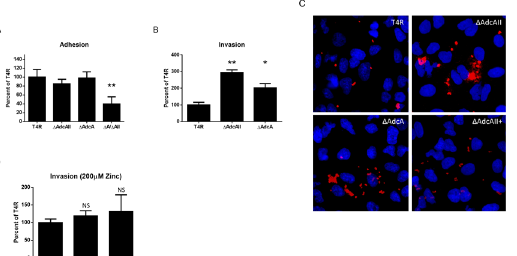
Fig 3. Effect of AdcA and AdcAII on adhesion and invasion in A549 cell line. A) Adhesion relative to T4R (100% representing approximately 0.9% of inoculum adhered). Bacteria were incubated with A549 cells for 30 mins in 24-well plates and adherent bacteria were quantitated. ** = P < 0.0005. B) Invasion relative to T4R (100% representing approximately 0.03% of inoculum invaded). Bacteria were incubated for 2 hrs with A549 cells, followed by 1 hr in the presence of antibiotics to kill extracellular bacteria; cells were lysed, and intracellular bacteria were quantitated. * = P < 0.005 and ** = P < 0.0005. C) Fluorescent images of A549 cells incubated with T4R, Δ AdcA Δ AdcAII, Δ AdcAII+ as in B. Cells were washed, permeabilized, and bacteria were stained with anti-TEPC-15 antibody (in red). Cell nuclei are stained with DAPI (blue). D) Invasion relative to T4R (%). Bacteria were incubated for 2 hrs with A549 cells with 200 μ M ZnSO 4 , followed by 1 hr in the presence of antibiotics to kill extracellular bacteria; cells were lysed, and intracellular bacteria were quantitated. All experiments were conducted at least three times. Each experiment consisted of triplicate sample